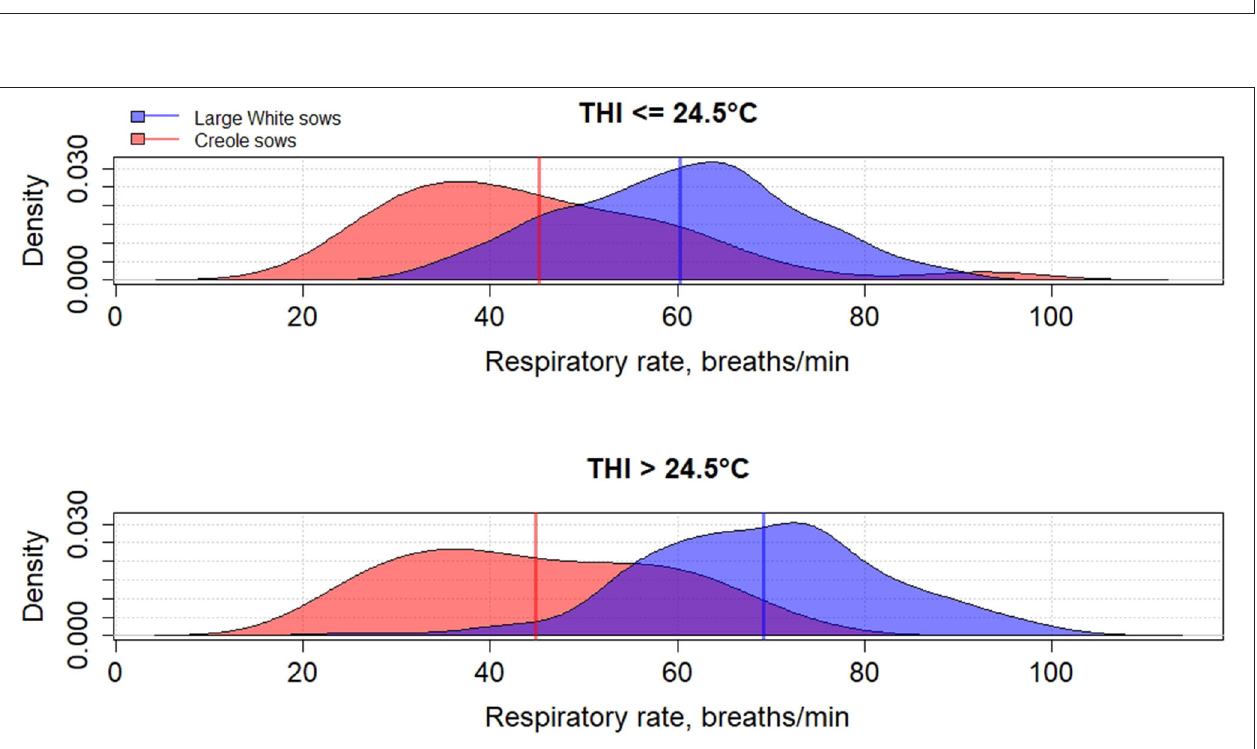
FIGURE 4 | Density distribution of average respiratory rate of Creole and Large White lactating sows according to the average thermal-humidity index (THI) during lactation [adapted from Gourdine et al. (59)].